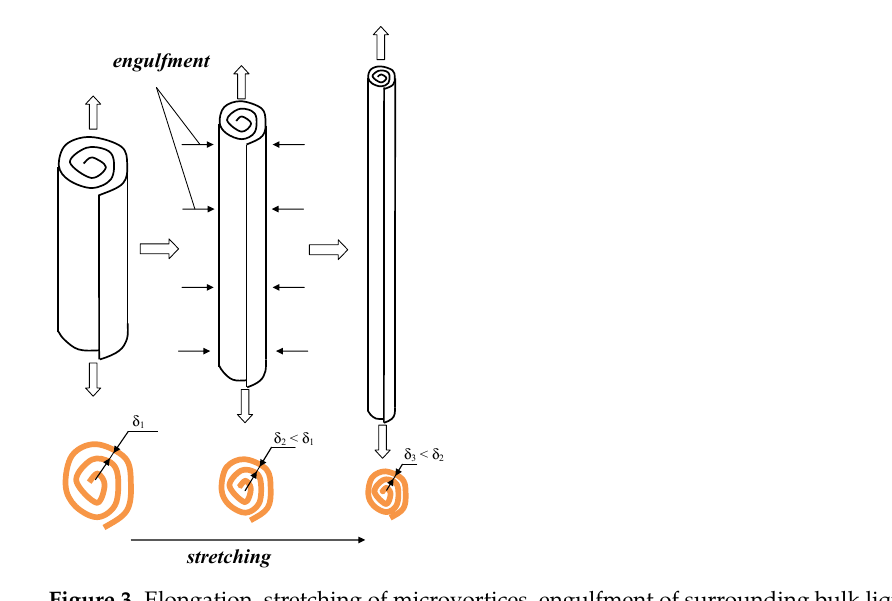
Figure 3. Elongation, stretching of microvortices, engulfment of surrounding bulk liquid.